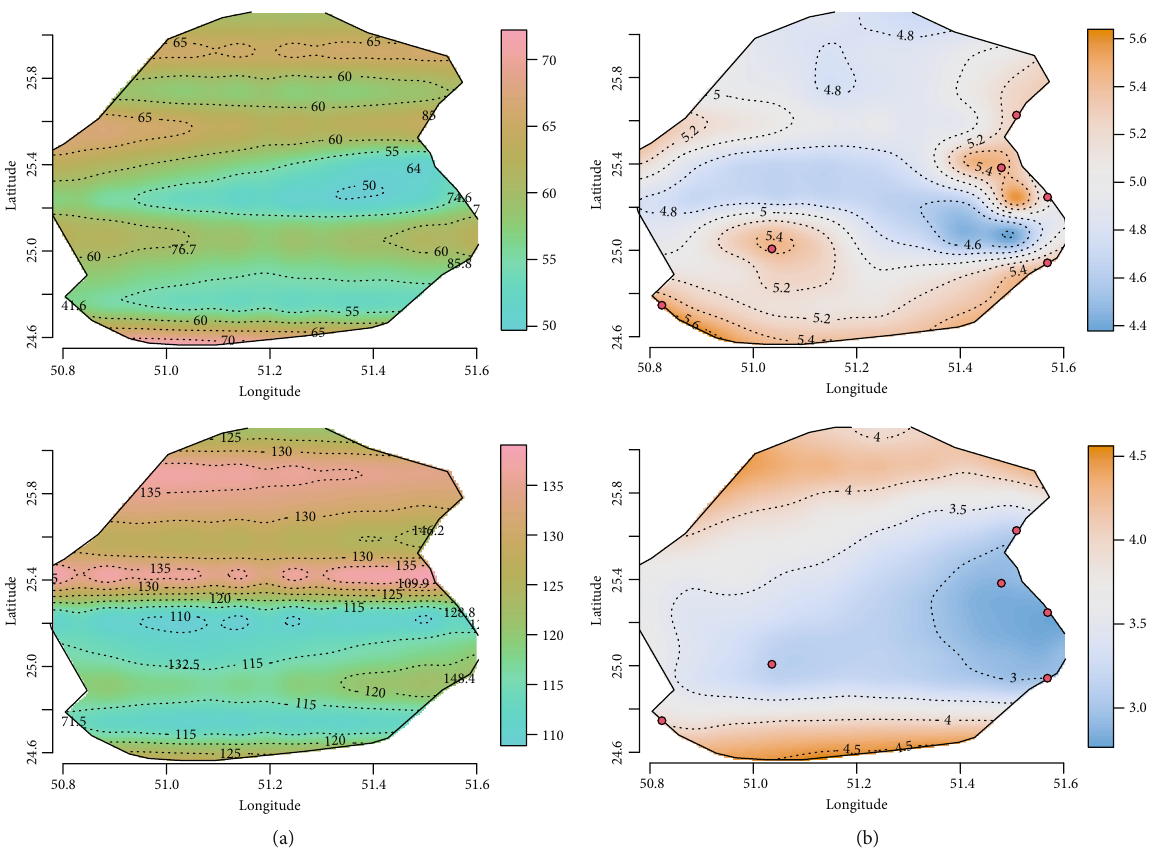
Figure 5: Spatially interpolated plots of the daily average of PM the AR model for the 29 th of March 2018 (top graphs) and 15 May of 2019 (bottom graphs). Actual values and associated locations are superimposed in plots,